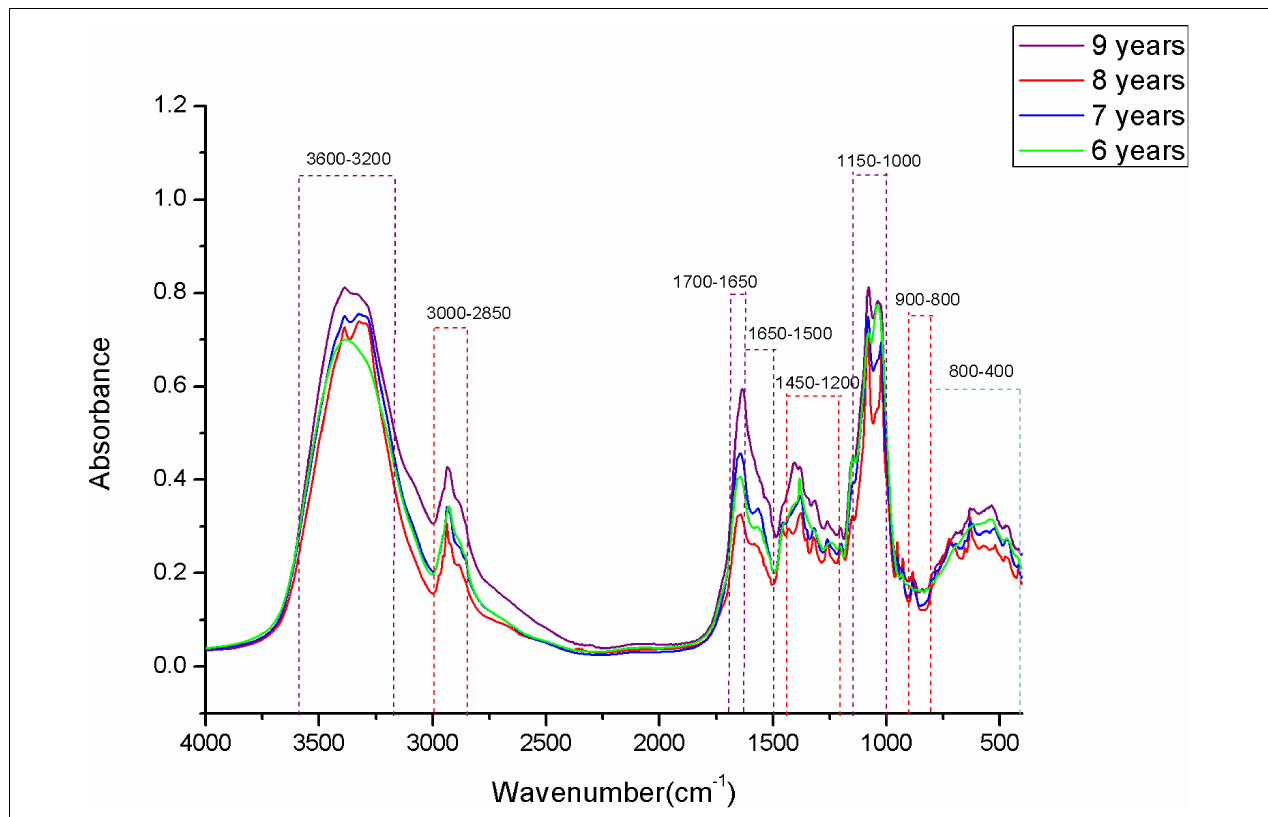
FIGURE 4 | The original MIR